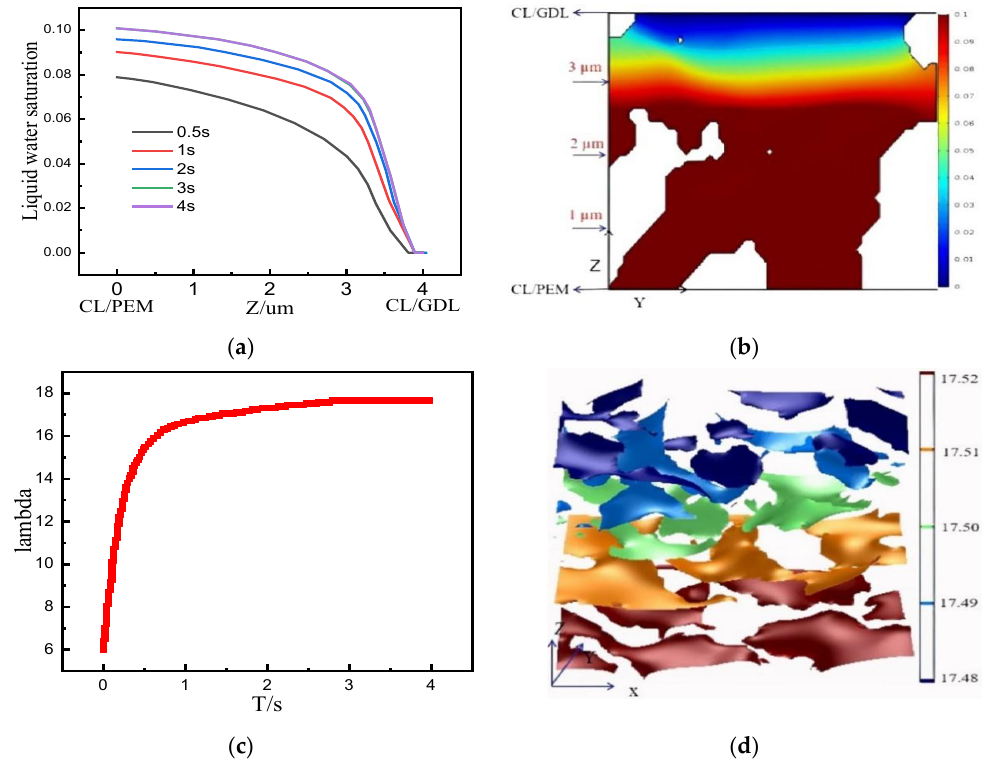
Figure 8. ( a ) The average liquid water saturation along the CL thickness direction at different moments. ( b ) Distribution of the average liquid water saturation on the y = 0 μm section when the reaction is stable. ( c ) Profiles of average ionomer water in the CL over time. ( d ) The iso-surface map of ionomer water along the thickness direction of the CL.